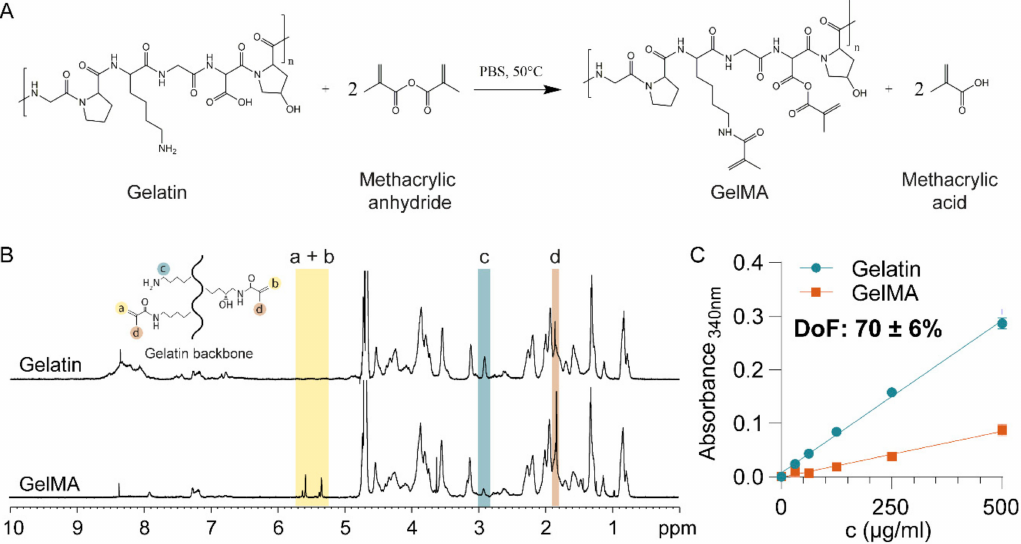
Figure 1. Gelatin Methacryloyl synthesis and characterization. ( A ) Gelatin Methacryloyl (GelMA) synthesis by methacrylation at 50 ◦ C produces GelMA and methacrylic acid. ( B ) Proton nuclear magnetic resonance ( 1 H-MNR) spectra of Gelatin and GelMA, confirming the substitution of primary amine groups by methacryloyl groups in GelMA. ( C ) Degree of GelMA functionalization, as measured by 2,4,6-Trinitrobenzene Sulfonic Acid (TNBS)